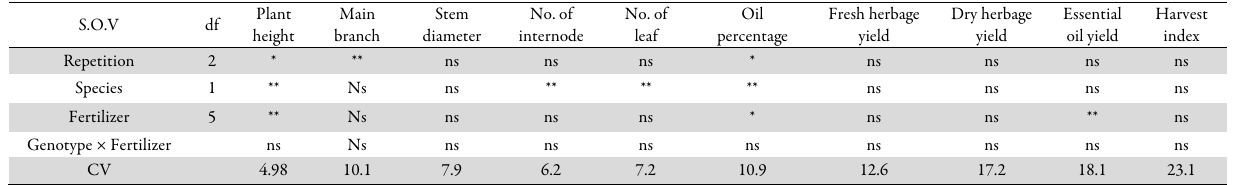
Table 2. Mean square values from analysis of variance (ANOVA) of yield and yield components of two species of mint under effect of genotype and fertilizer